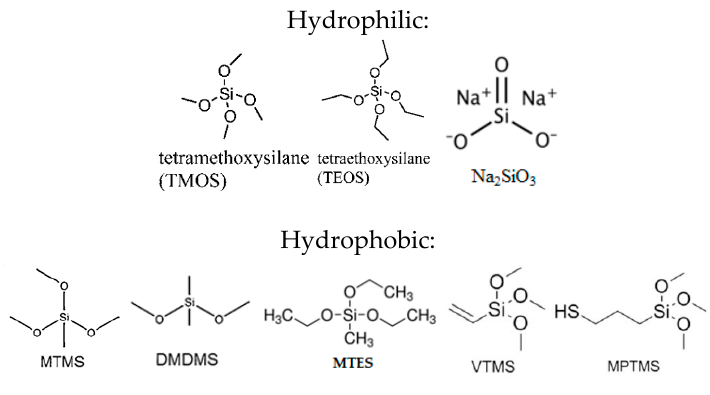
Figure 2. Common precursors for silica aerogels applied in CO 2 capture.